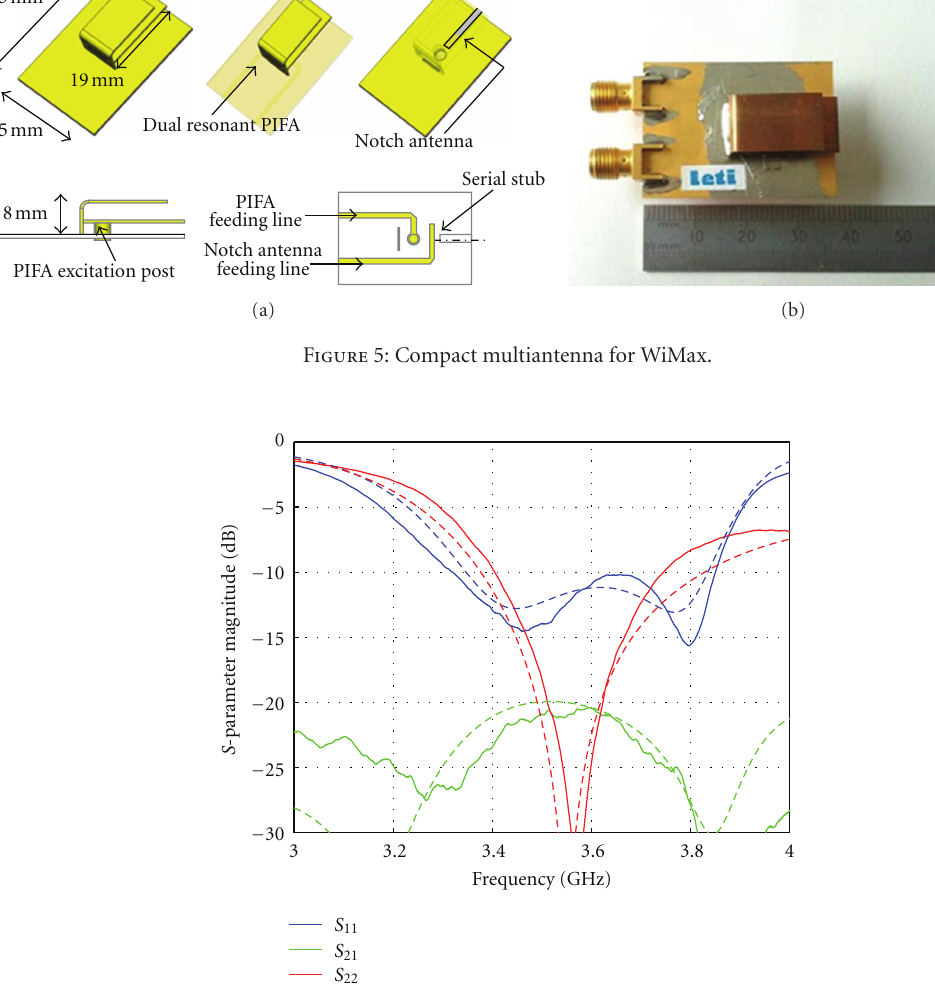
Figure 6: Scattering parameters of compact multiantenna prototype. Solid line is measurement, dashed is simulation.